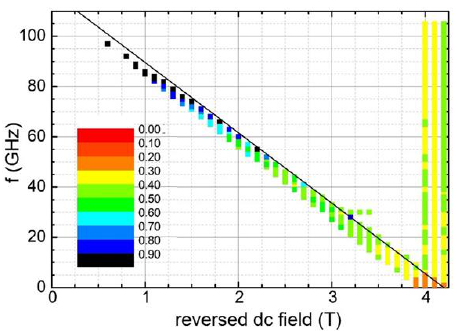
Figure 2. Conditions (exciting frequency vs. applied reversed field) under which reversal occurs within 1 ns for a CoPt disk with diameter 16 nm and thickness 4 nm, covered by a 2 nm Co 3 Pt layer. The color code represents the switching time in nanoseconds. A particular color is used for switching time, which is between the values indicated at its two edges. The solid black line represents the Kittel condition f = γ ( 4.2 T − H )